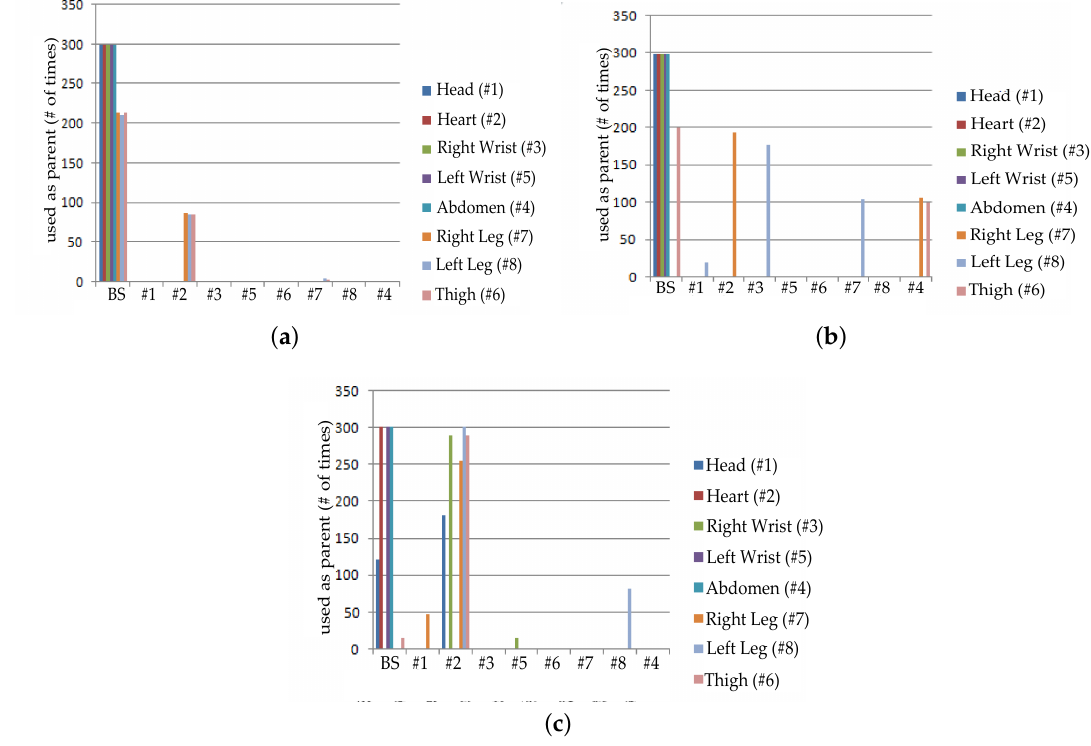
Figure 16. No. of hops while sitting activity. ( a ) At TX 2 ; ( b ) At TX 3 ; ( c ) At TX 4 .